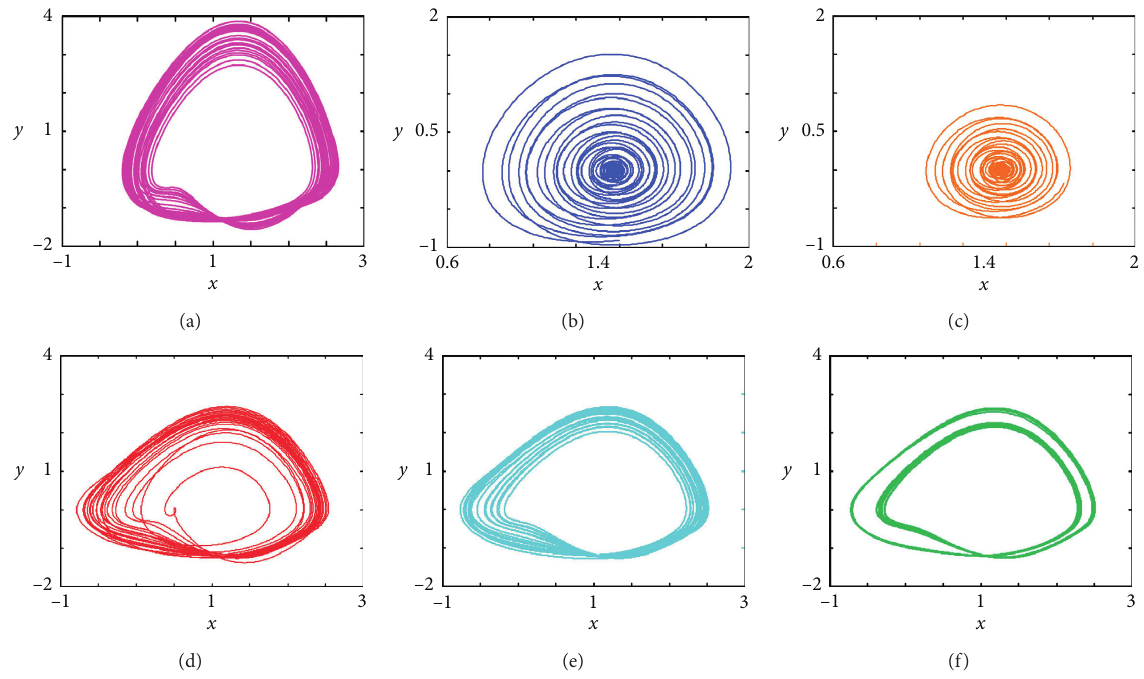
Figure 9: Coexisting attractors with different conditions: (a), (b), (c) q � 0.98, s � 10, and the initial conditions are [0.005, 0.005, − 0.1, 0.1], [0.5, 0.005, − 0.1, 0.1], and [0.58, 0.005, − 0.1, 0.1]; (d), (e), (f) q � 0.99, s � 5, and the initial conditions are [ − 0.9, 0.1, − 0.1, 0.1], [ − 0.9, 0.2, − 0.1, 0.1], and [ − 0.9, 0.82, − 0.1, 0.1].